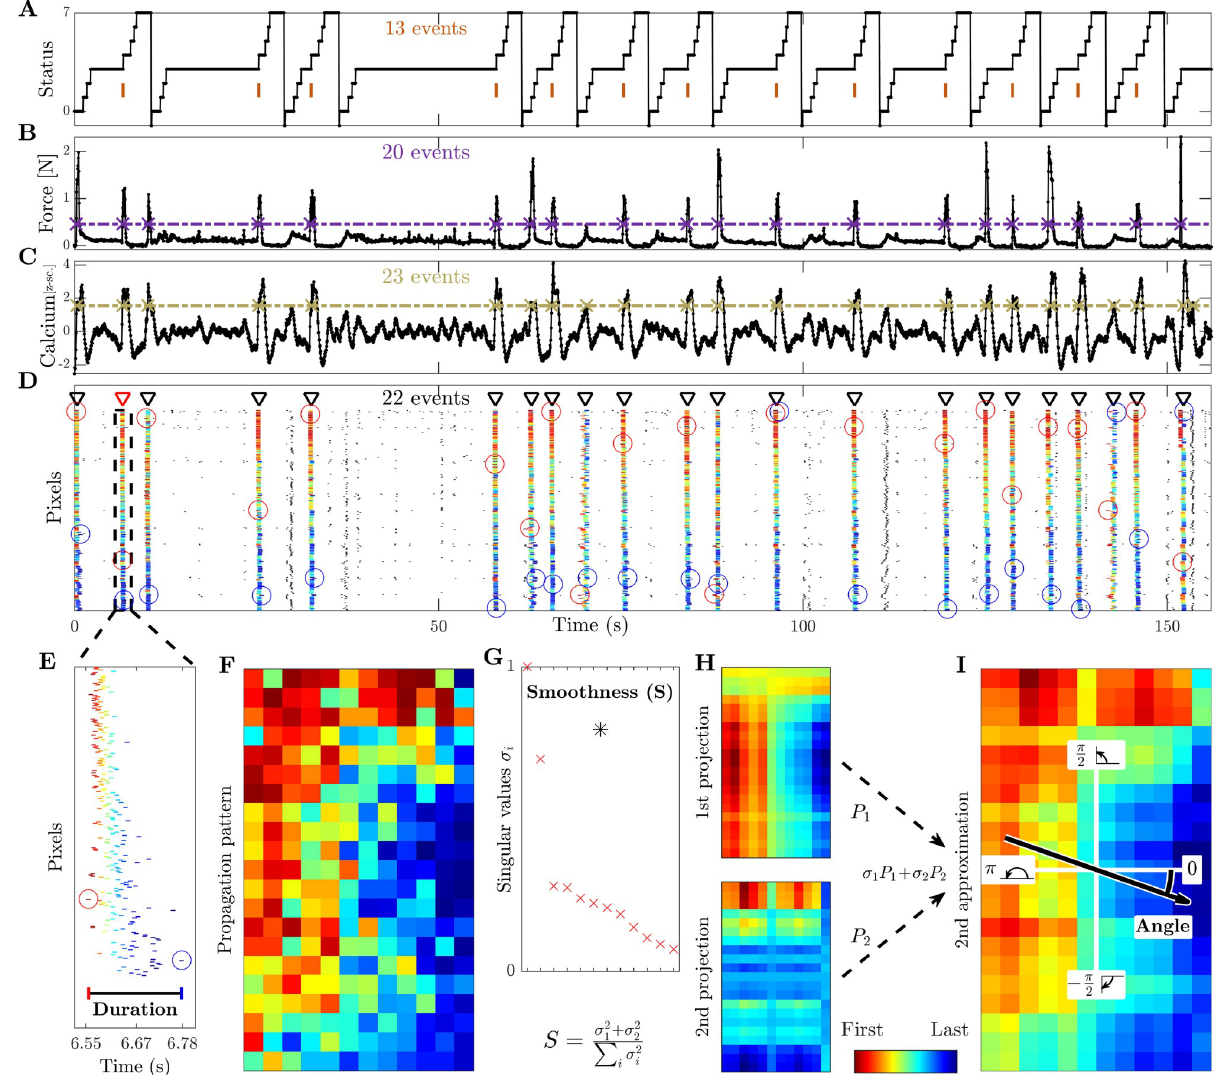
Fig 2. Event identification, propagation analysis, and definition of three propagation indicators: Duration, smoothness, and angle. (A) Status of the robotic slide. The longer horizontal plateaus at status 3 correspond to the time interval during which the mouse is allowed to retract the slide. The orange bars refer to the time when the pull is completed and the mouse receives its reward. (B) Force applied by the mouse during the retraction movement. (C) Average calcium signal over all pixels. The purple and yellow dashed lines below refer to the threshold used to identify the force peaks and the global calcium events, respectively. (D) Raster plot obtained from the threshold crossings of individual pixels versus time. Triangle indicators show the global events identified during this session, and the red triangle with dashed box marks the event analyzed in the remaining panels below. The first (last) spike of each global event is marked by a red (blue) circle. Within each subplot (a)-(d) we state the number of the respective events / threshold crossings. (E) Zoom of this selected event. The duration is defined as the interval from the first to the last spike within the event. (F) The propagation matrix is obtained by projecting the relative order of these threshold crossings onto the 2D-recording plane. (G) Singular values (red) vs. order of approximation, obtained by means of singular value decomposition (SVD). The smoothness (black asterisk) measures the quality of the second order approximation. (H) First and second approximations of the propagation matrix and (I) second order approximation as their weighted sum (cumulative). The angle of the propagation, defined relative to the horizontal axis. all spikes which were not coincident with spikes in at least three quarters of the other spike trains. To the global events that remained we applied the asymmetric SPIKE-order indicator [23] which quantifies the leader-follower relationship between pairs of spikes. For each event the SPIKE-order is then color-coded from leader (red) to follower (blue). Finally, we used the